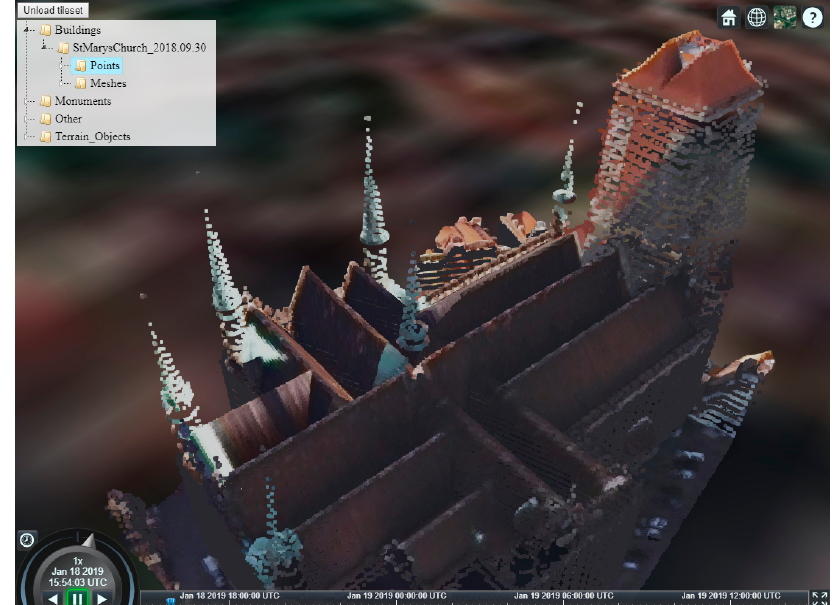
Figure 5. The system's Web-GIS client displaying the original point cloud of the processed dataset.